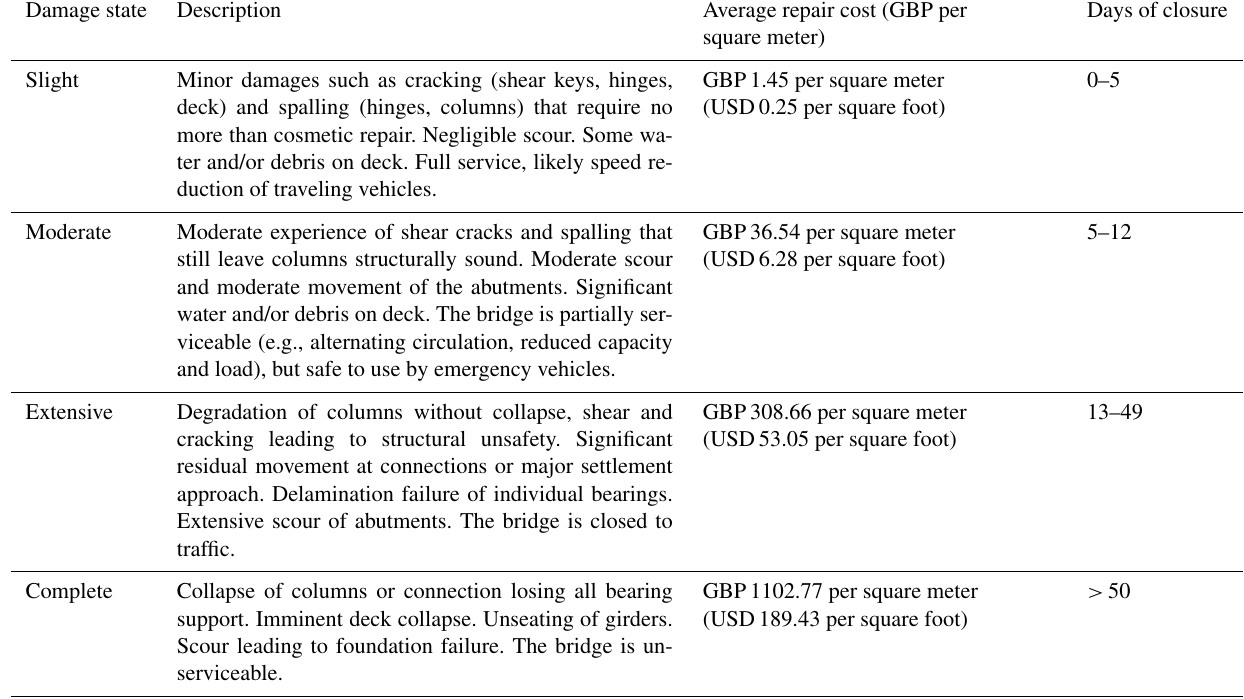
Table 1. Bridge damage states (Gehl and D’Ayala, 2018) associated with average repair cost per square meter (Padgett et al., 2008; FEMA, 2003) and average days of closure due to repair (Porter et al., 2011; Gardoni, 2018; Lam and Adey,